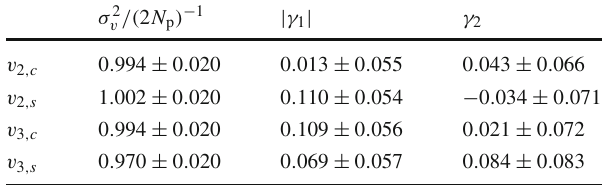
Table 5 Moments of the probability distributions displayed in Fig. 8 for the anisotropic flow harmonics in the initial state computed for 5000 events at b = 9 fm. The variance σ 2 v is divided by the estimate 1 / 2 N